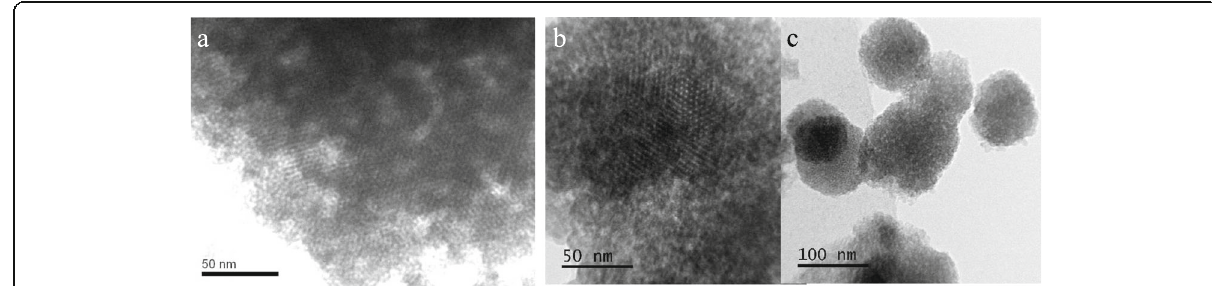
Fig. 3 TEM images of β -CD-APTES-MCM-41 ( a ), β -CD-APTES 3 -MCM-41 ( b ), and β -CD-APTES 5 -MCM-41 ( c ) silicas